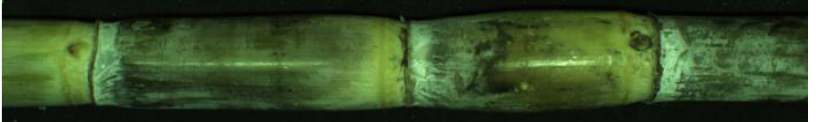
Figure 7. Sugar cane images.